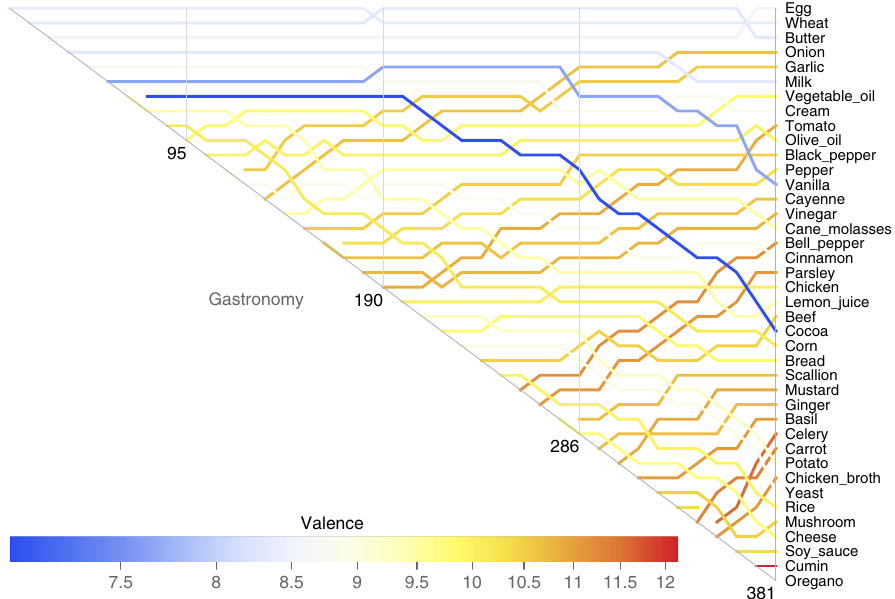
Fig. 4 How valence affects the relative usefulness of components over time. Here we show Fig. 2b, but with the component curve colours set by component valence at stage N . More valent components tend to rise in relative usefulness, and less valent components tend to